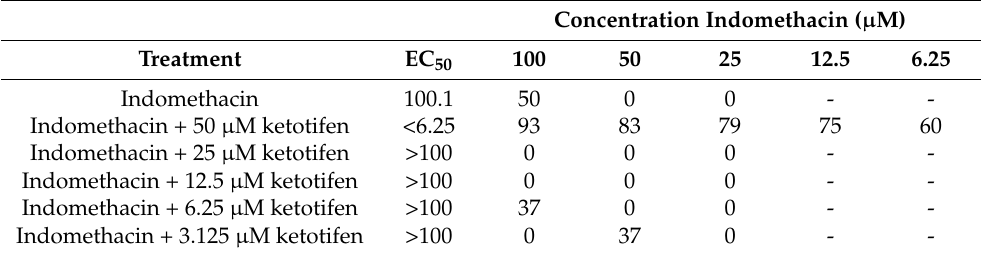
Table 4. EC 50 and percentage inhibition of SARS-CoV-2: 100 µ M indomethacin in combination with